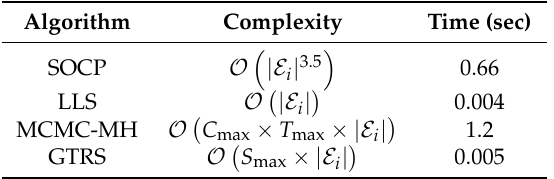
Table 2. Analysis of computational complexity and average execution